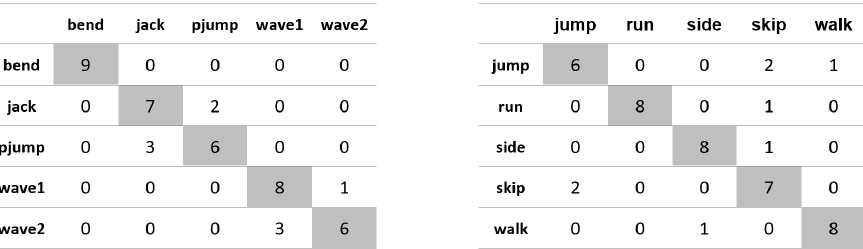
Figure A25. Confusion matrices for the experiment using the ‘upper-occlusion’ database, longerMBR and Euclidean distance.